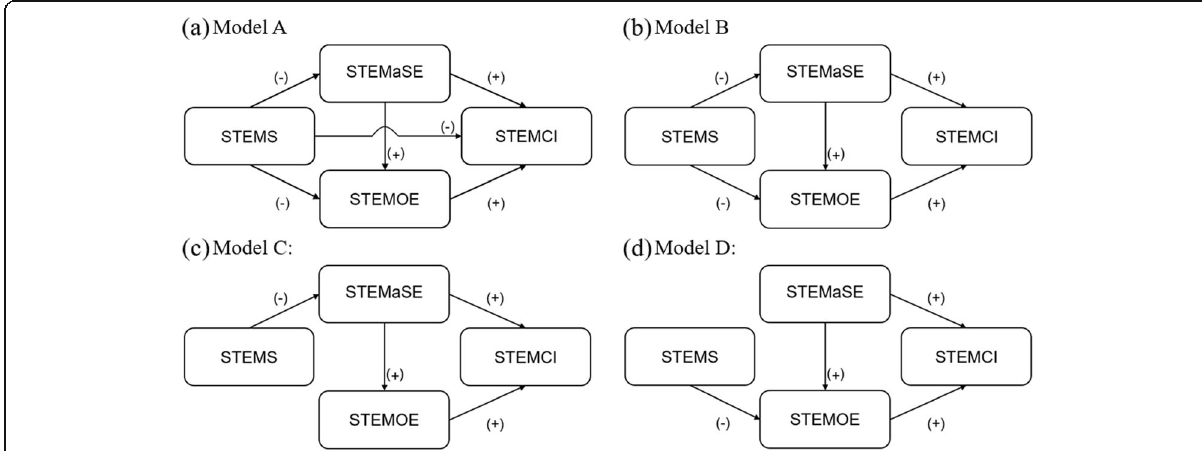
Fig. 3 Four models tested in the study